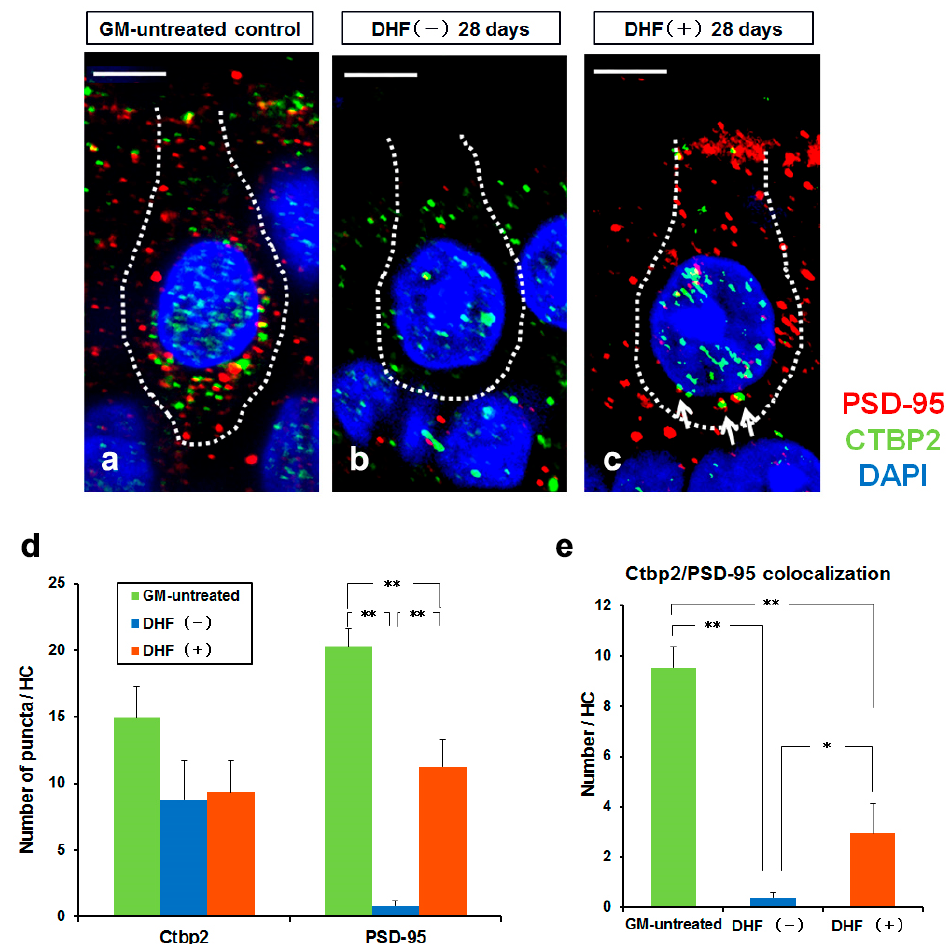
Figure 5. Synaptic analysis. ( a – c ) Confocal images of the crista ampullaris stained with PSD–95 antibody (red), CTBP2 antibody (green), and DAPI (blue). The dotted lines show the outline of HCs. ( a ) The GM–untreated controls have many PSD–95 positive and CTBP2 positive puncta